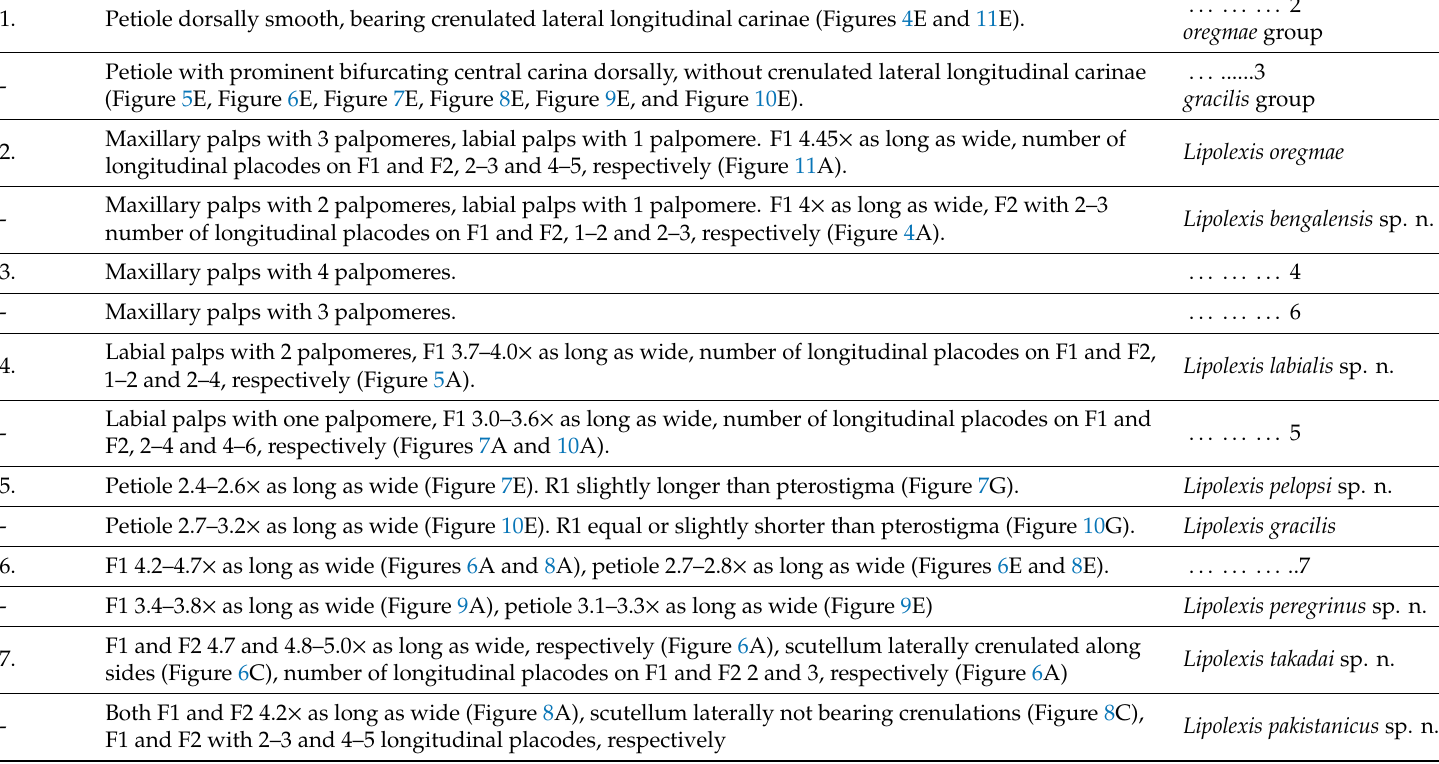
Both F1 and F2 4.2 × as long as wide (Figure 8A), scutellum laterally not bearing crenulations (Figure 8C), F1 and F2 with 2–3 and 4–5 longitudinal placodes, respectively